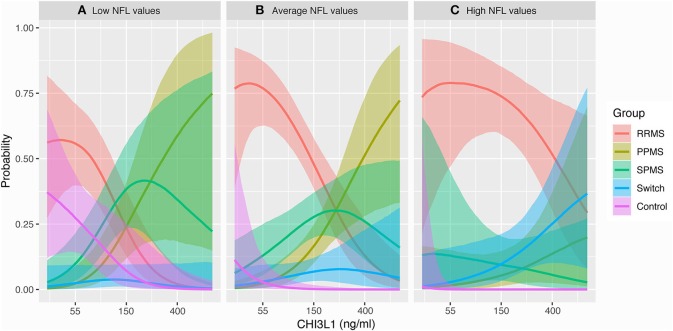
Marginal effect plots. This plot is the graphical representation of the multinomial regression model performed and shows the probability to be comprised in a MS clinical form, including the probability of conversion to SPMS, with regards to CSF NFL, and CHI3L1 levels. Thus, this diagram shows the interaction between both biomarkers. (A) When levels of NFL are low, low CHI3L1 levels imply higher probability to be a non-MS control (pink) or a RRMS patient (red). High CHI3L1 levels in these patients are associated with the diagnosis of progressive MS (green and brownish green). Probability of switching to SPMS is very low. (B) With average levels of NFL, the probability of pertaining to a non-MS control decreases, and CHI3L1 levels discriminate better between RRMS (low CHI3L1), and PPMS (high CHI3L1). (C) With high NFL levels, the probability of being comprised in the RRMS group is the highest. High NFL and CHI3L1 are more probable in patients diagnosed of SPMS during follow-up, and in a subgroup of PPMS patients, likely PPMS patients with active disease. NFL, neurofilament light chain; CHI3L1, chitinase-3-like-1; RRMS, relapsing-remitting multiple sclerosis; SPMS, secondary progressive multiple sclerosis; PPMS, primary progressive multiple sclerosis; Switch, diagnosis of SPMS during follow-up.